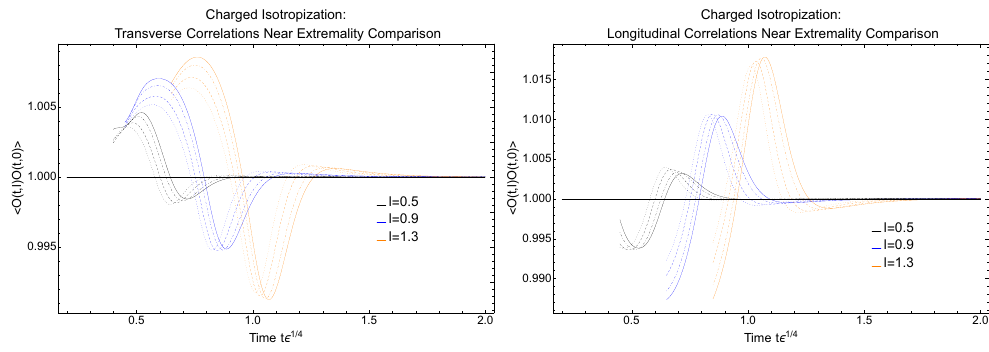
Figure 12 . 2-point correlation functions calculated for a scalar operator in a charged thermalzating (cid:13)uid (RN black brane geometry). Left: various length separations in the transverse direction. Right: various length separations in the longitudinal direction. In all plots dotted lines represent (cid:26) = 0, dashed lines represent (cid:26) = 0 : 78 (cid:26) e , dot-dashed lines represent (cid:26) = 0 : 95 (cid:26) e and solid lines represent (cid:26) = 0 : 975 (cid:26) e